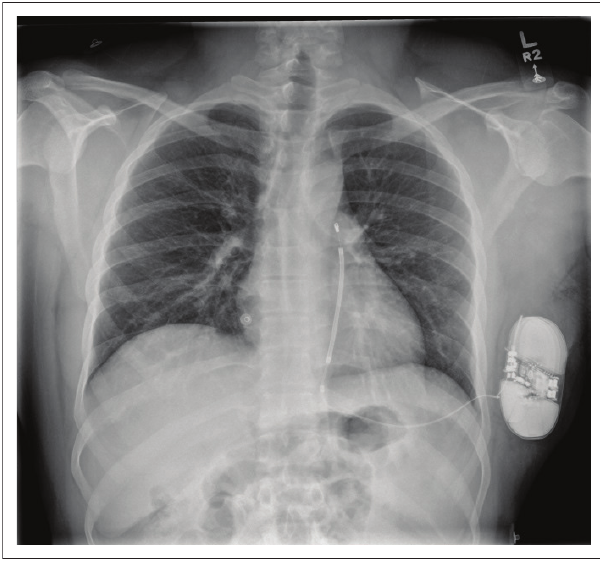
FIGURE 6: A subcutaneous implantable cardioverter defibrillator implanted in a 27-year-old male patient with hypertrophic cardiomyopathy. FIGURE 7: A chest radiograph showing a doughnut magnet placed over a pacemaker.